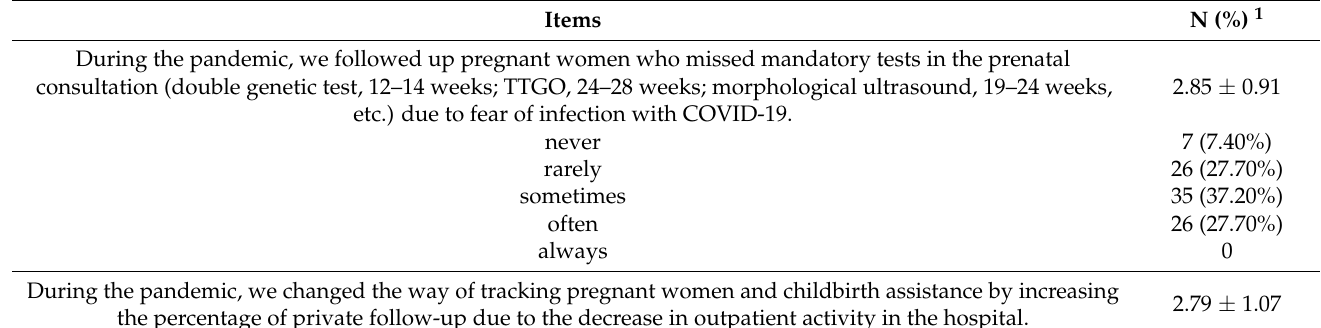
Table 4. The frequency of items investigating the changes in clinical